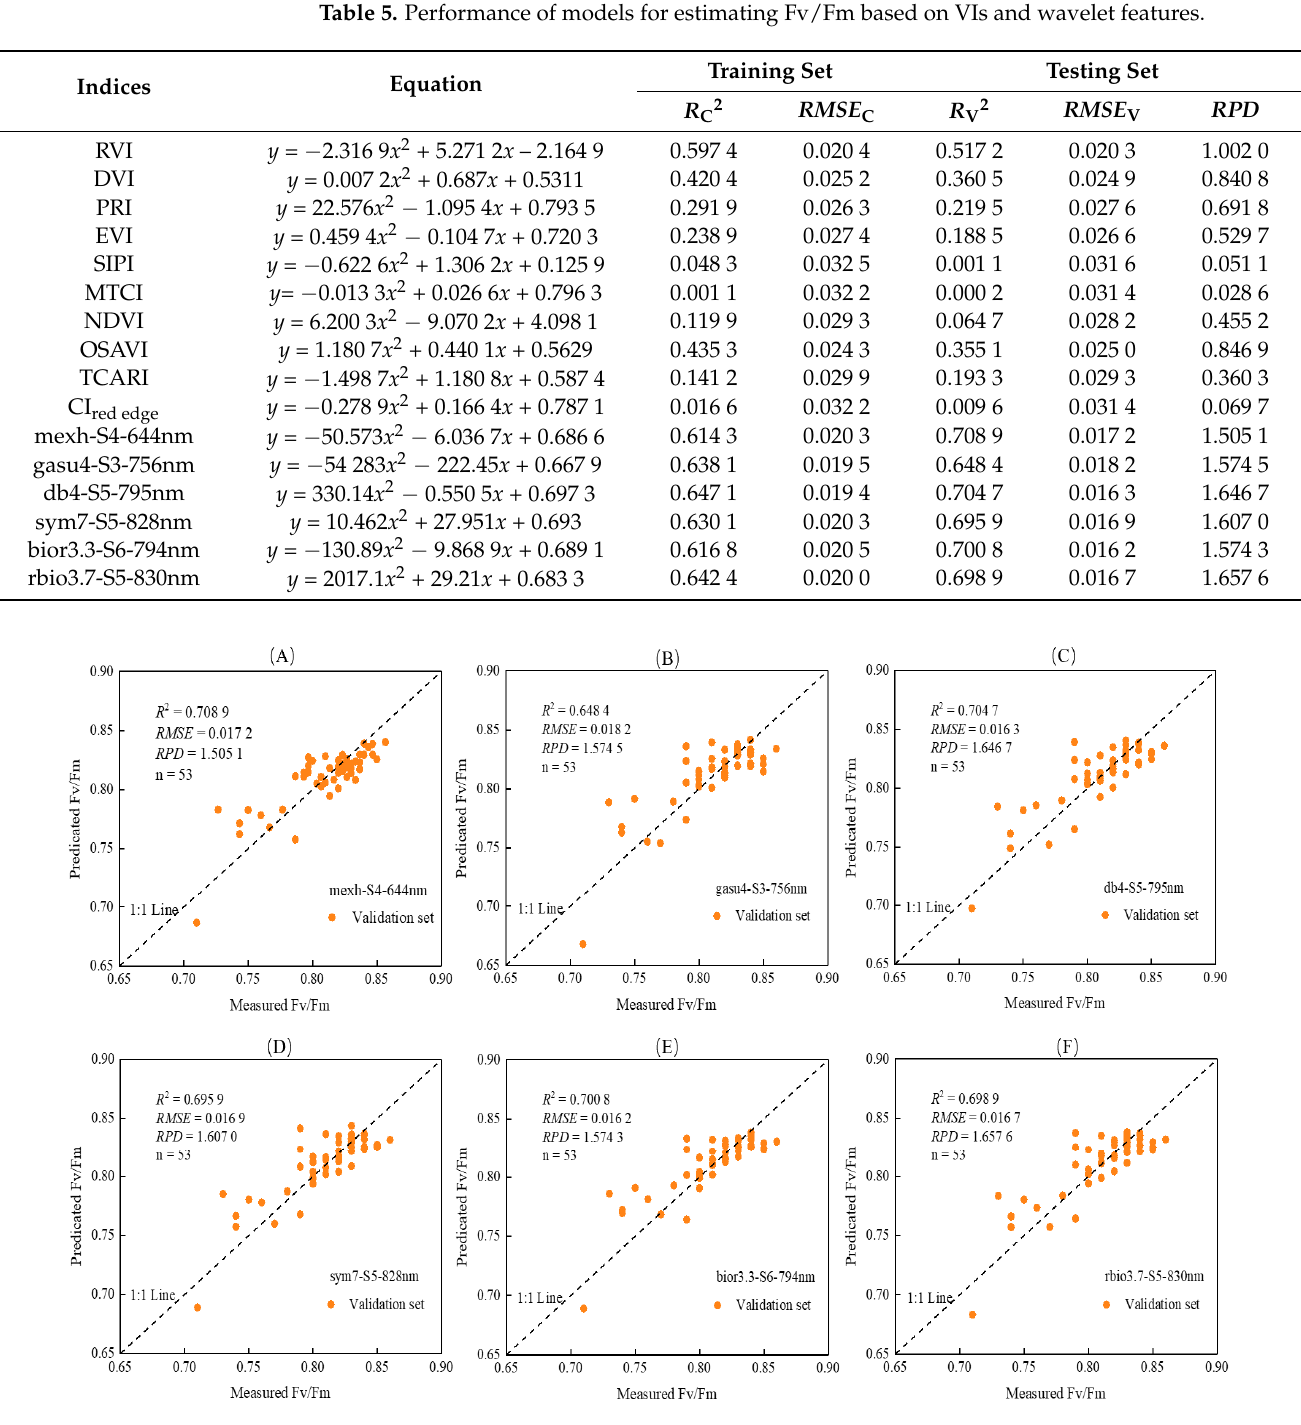
Figure 6. 1:1 relationship between predicted and measured values of Fv/Fm based on different mother wavelet functions. ( A ) mexh, ( B ) gasu4, ( C ) db4, ( D ) sym7, ( E ) bior3.3, ( F ) rbio3.7.